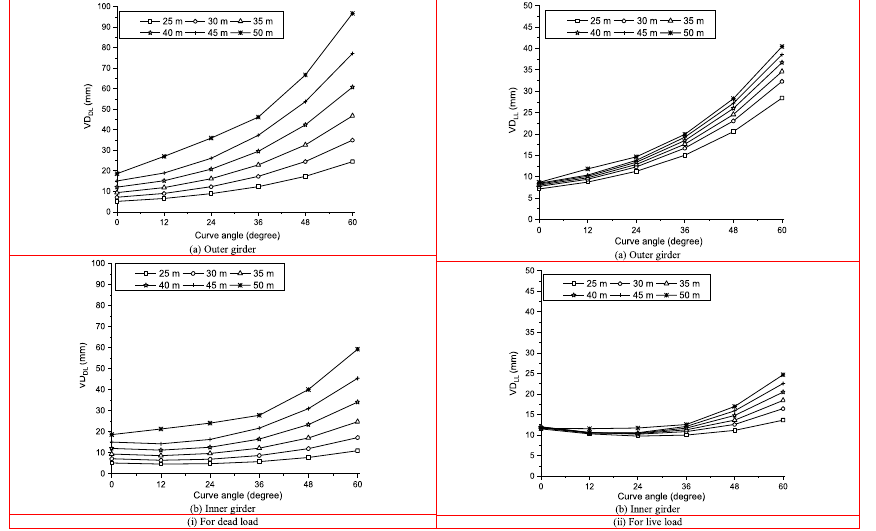
Fig. 12 Variation of vertical deflection with curve angle for different span. a Outer girder. b Inner girder. (i) For dead load. (ii) For live